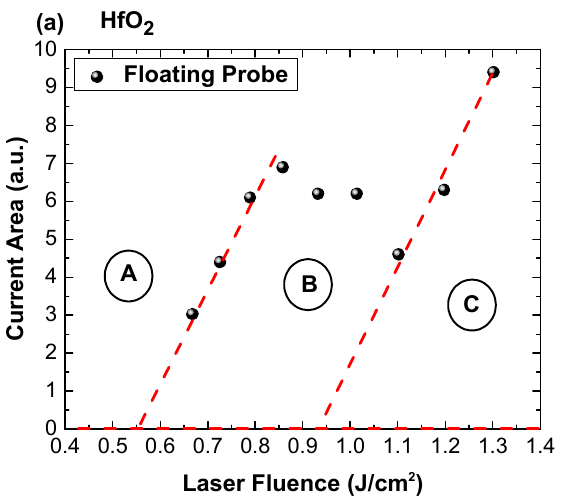
Figure 4. Total area of the LP current as a function of laser fluence for HfO 2 ( a ) and ZrO 2 ( b ). Further investigations concern a comparative representation of charge currents charac- terizing each specific area (Figure 5a for HfO 2 and Figure 5b for ZrO 2 ). This representation highlights the transition discussed in Figure 2 and adds context in terms of the relation between the irradiation conditions and the ablation threshold. It can be clearly seen that for fluences below the threshold value found here, the charge currents are characterized by a long lifetime (around 800 µ s for both materials). In these irradiation conditions it is difficult to assume any acceleration of the ions. The best scenario that would describe the observed behavior is the laser cleaning effect (i.e., removal of weakly bounded particles and adsorbed molecules). This process precedes any thermal mechanism and it can be described by low electrostatic interactions. Around the threshold value, the current temporal trace presents multiple maxima, which suggests the presence of multiple ionized species reaching the probe at different moments in time. This separation implies the presence of an accelerating field, which induces the separation based on a charge-to-mass ratio value. Around the threshold value, the gentle ablation regime was identified, as defined by N. Bulgakova’s group in [28], as being defined by long lifetime with contributions from various ionized states. A significant change is seen through the appearance of a highly energetic group of ions and increase of about one order of magnitude in the overall charge density. Above the threshold, the complete temporal range of the charge currents significantly changes with a positive ionic contribution seen in the tens of µ s regime. This is consistent with other reports for laser produced plasma [35]. It is worth noting that in all investigated conditions a negative contribution was observed, which is characterized by a short arrival time and a consistent density of one order of magnitude lower than the main ionic peak. The